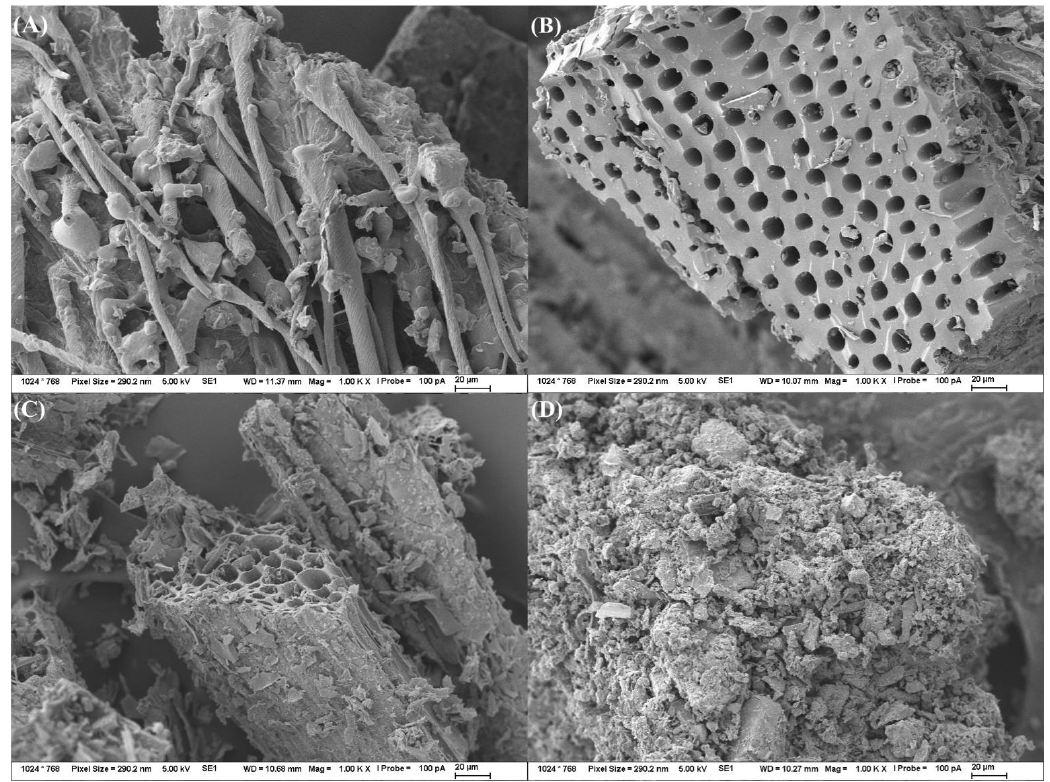
Figure 2. SEM images (magnification 1000×) of biochar produced at 600 °C (residence time 60 min) from individual biomass feedstocks — ( A ) oat brans; ( B ) woodcut; ( C ) corn residual biomass; ( D ) commercial compost.